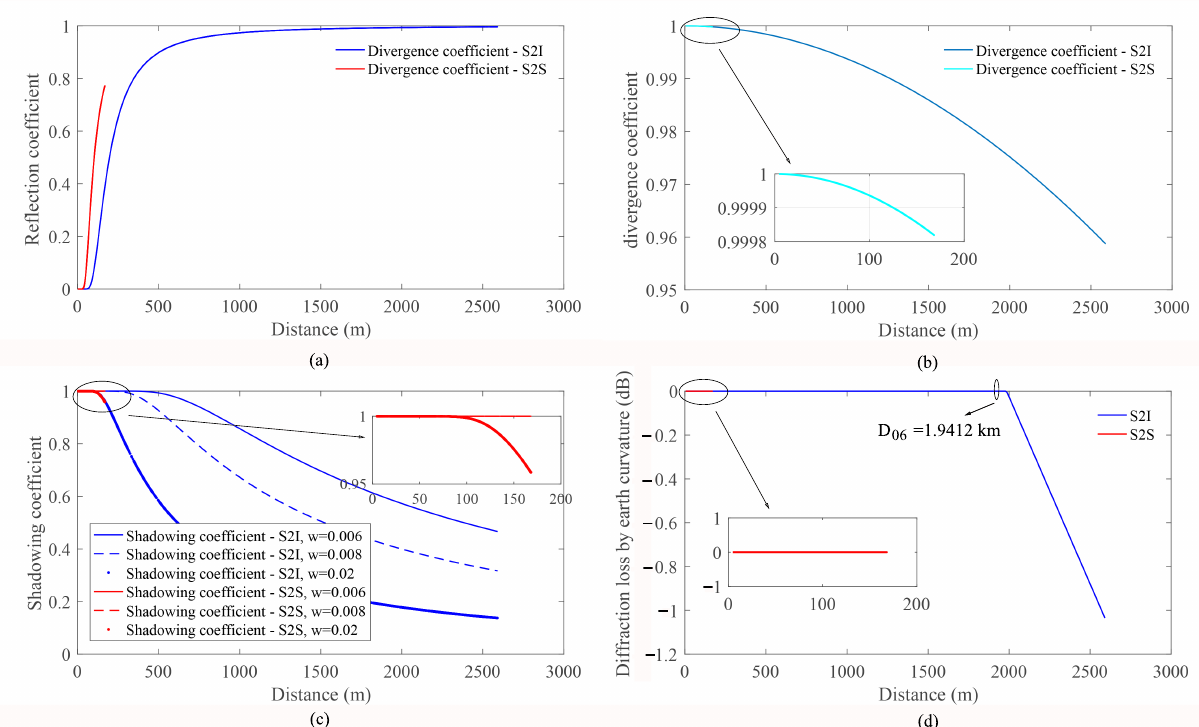
Figure 5. Effect factors. ( a ) effective reflection coefficient from water surface, ( b ) divergence coefficient, ( c ) shadowing coefficient, and ( d ) diffraction loss caused by earth